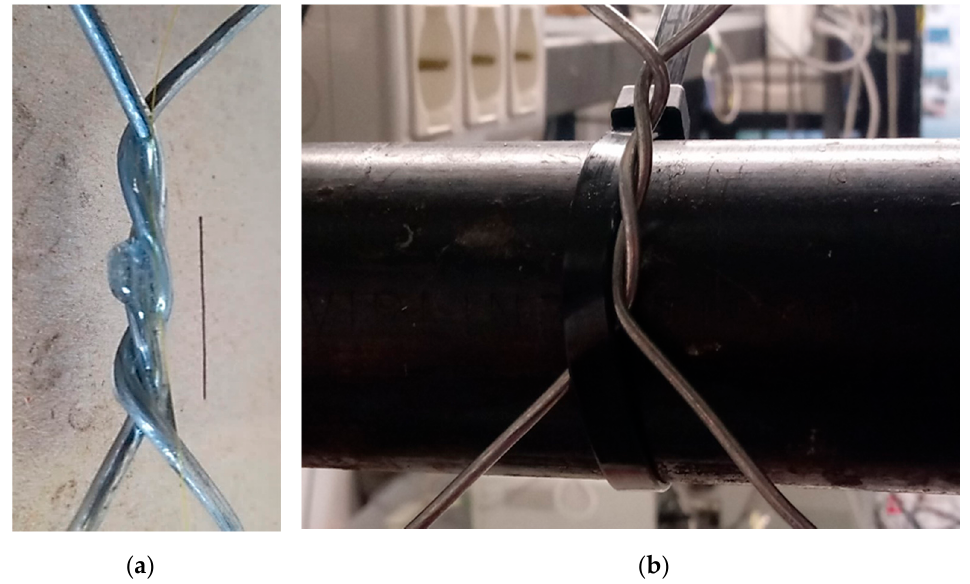
Figure 4. Details of the experimental setup: ( a ) OF glued at the double-twisted sections; ( b ) constraints applied to the DTWM.